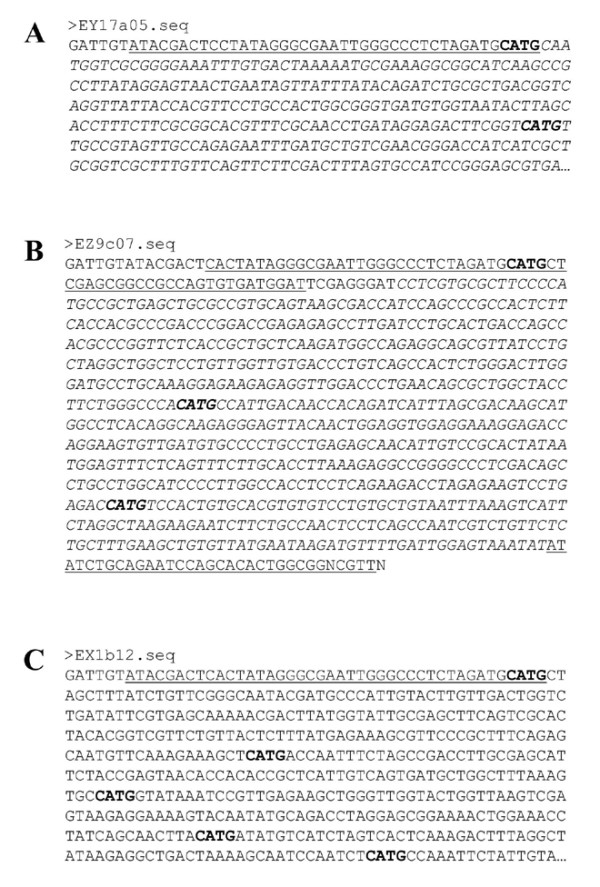
Raw SAGE sequence data showing cloning and potential sequencing artifacts excluded by SAGE software. (A) Clone with fragment of E. Coli genomic DNA. Italics denote E. Coli sequence (AE000256). (B) Clone containing a fragment of rodent genomic DNA. Italics denote M. musculus sequence (AI894042). (C) Clone with unidentifiable insert, which lack normal SAGE concatemer. pZErO-1 sequences are underlined; Anchoring enzyme recognition sites (AERS(CATG)) are shown in bold.